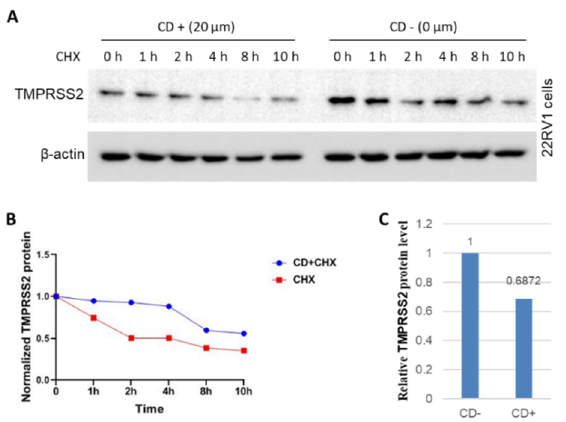
Figure 6. Treatment with CD inhibits the translation and promotes the degradation of TMPRSS2 in 22RV1 cancer cells. ( A ) TMPRSS2 protein stability after CHX treatment with or without CD treatment. The left panel shows CD treatment, and the right panel shows without CD treatment. ( B ) Quantitative results from A. The red line shows CHX treatment only, and the blue line shows CHX + CD treatment. Please note that the amount of TMPRSS2 protein in CD+ treatments remained lower over the entire period than that in CD − . ( C ) Quantitative results’ comparison of TMPRSS2 protein levels without and with CD treatments but without CHX treatments in Figure 6A. Left column shows without CD treatments (CD − ), while right column shows with CD treatments (CD+). The final concentration of CHX was 40 µ g/mL. h, hour (s) of CHX treatment. In the left panel of Figure 5A, all the lanes were added CD for 1 h prior adding CHX